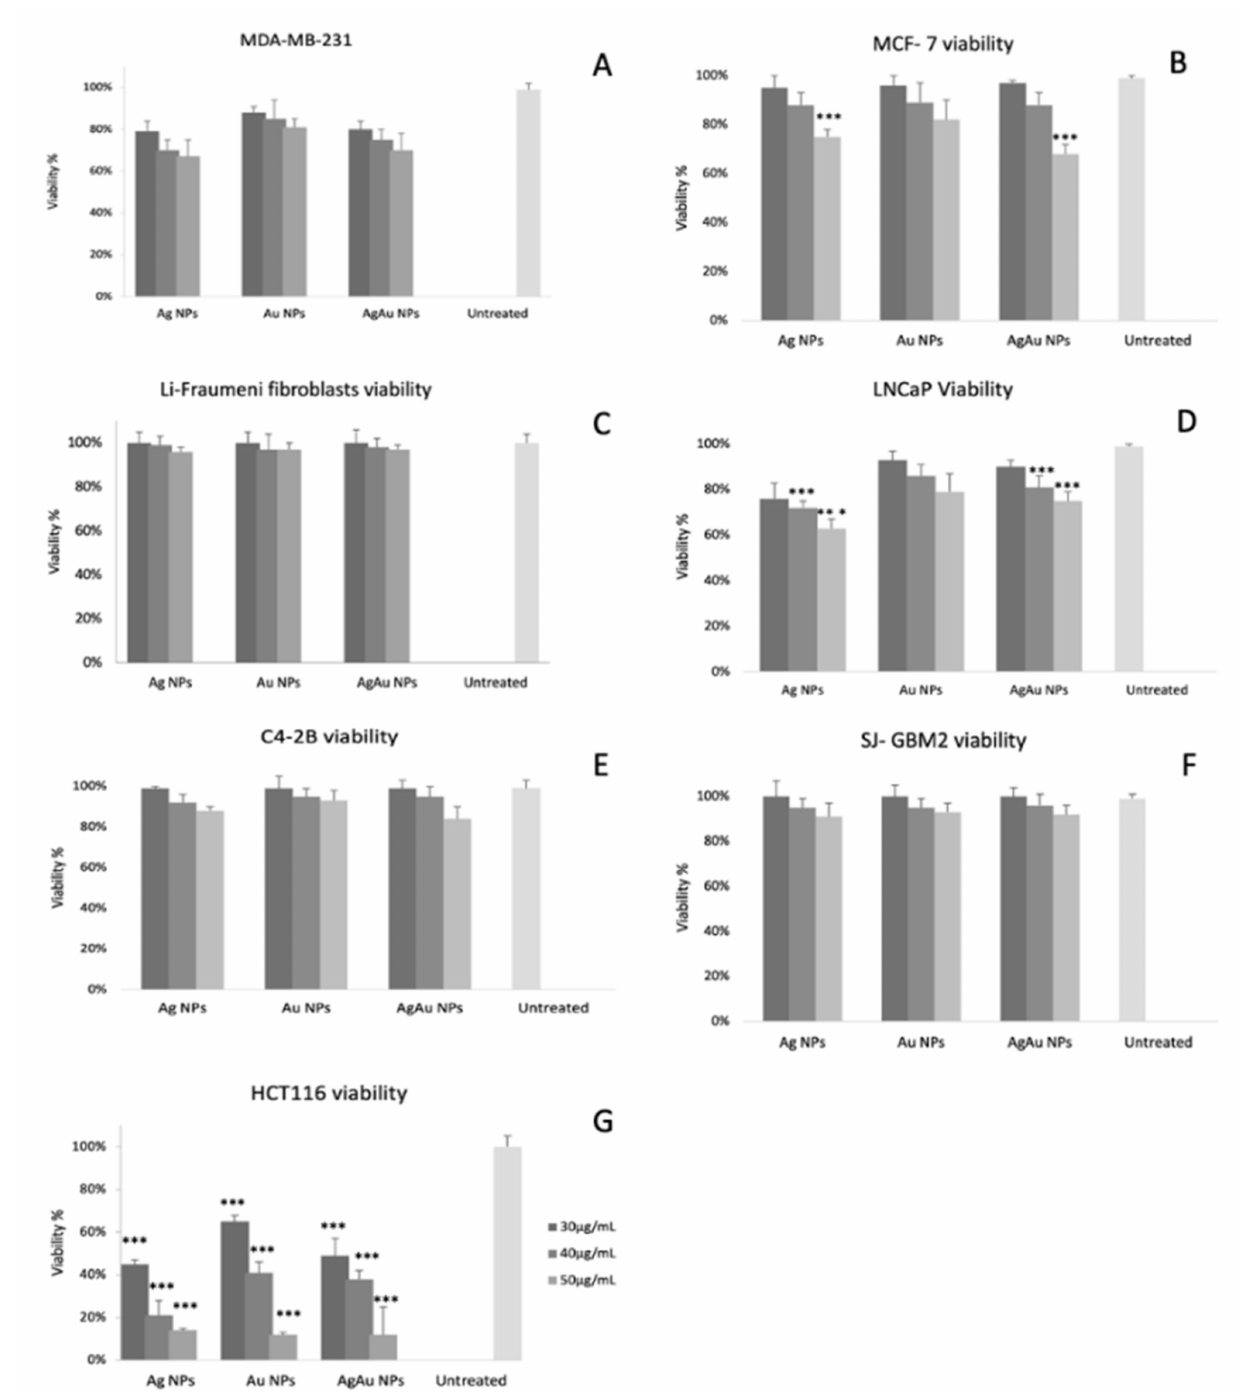
Figure 3. Viability percentage of all cancer cell lines (MDA-MB-231, MCF-7, fibroblasts derived from Li-Fraumeni patients, LNCaP, C4-2B, SJ-GBM2 and HCT116) in panels ( A – G ) respectively, incubated with NPs (Ag NPs, Au NPs, AgAu NPs) for 23 h. The *** symbol shows statistical significance using one way ANOVA ( p < 0.05) compared to untreated